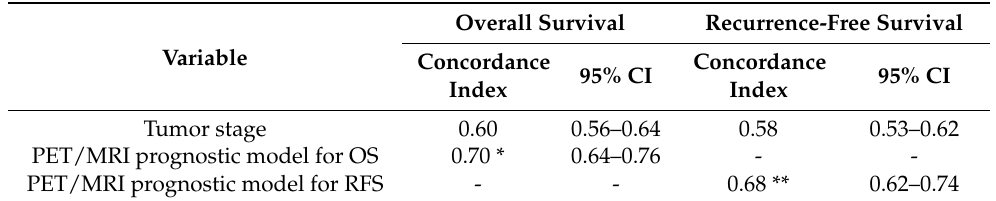
Table 5. Comparison of Harrell’s concordance indices between tumor stage and prognostic models based on clinical factors and PET/MRI biomarkers. Overall Survival Recurrence-Free Survival Variable Concordance Concordance 95% CI 95% CI Index Index Tumor stage 0.60 0.56–0.64 0.58 0.53–0.62 PET/MRI prognostic model for OS 0.70 * 0.64–0.76 PET/MRI prognostic model for RFS